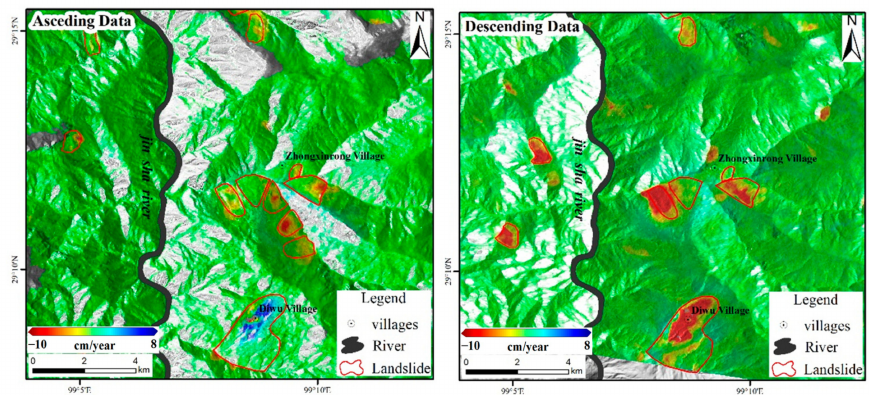
Figure 15. Comparison of landslide identification results from ascending and descending orbit data.